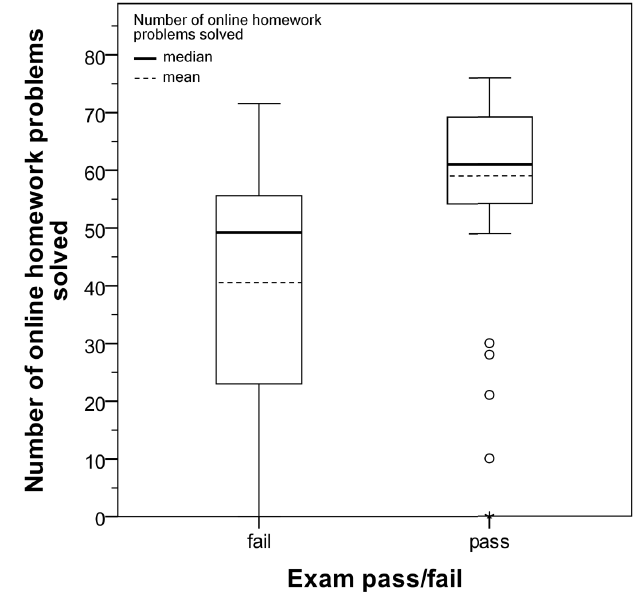
Fig. 4. Comparison of the number of online homework problems solved between students who passed or failed the